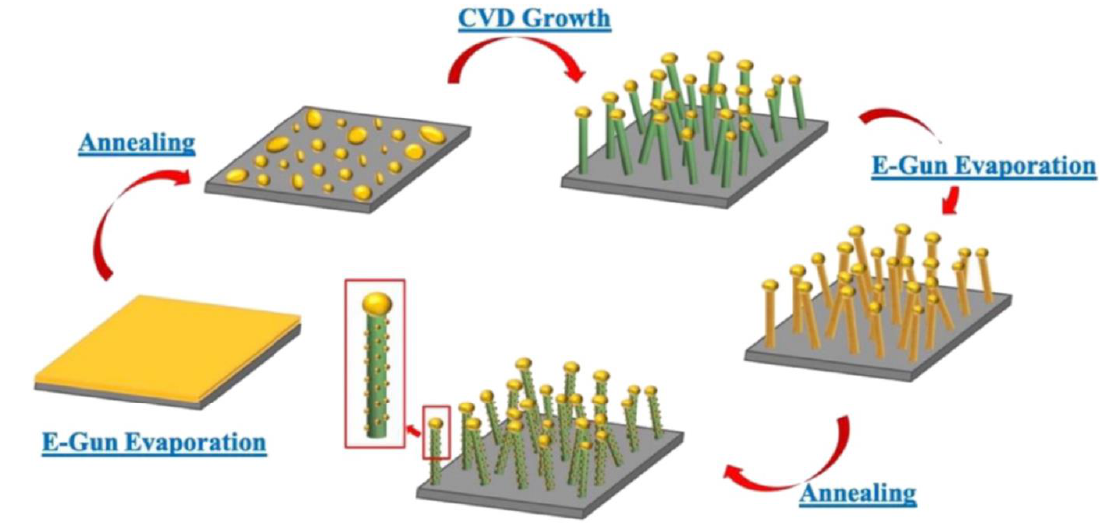
Figure 7. Schematic diagram of the fabrication of the Au NP/Zn x Cd 1 − x S NW heterostructure. Reproduced with permission from